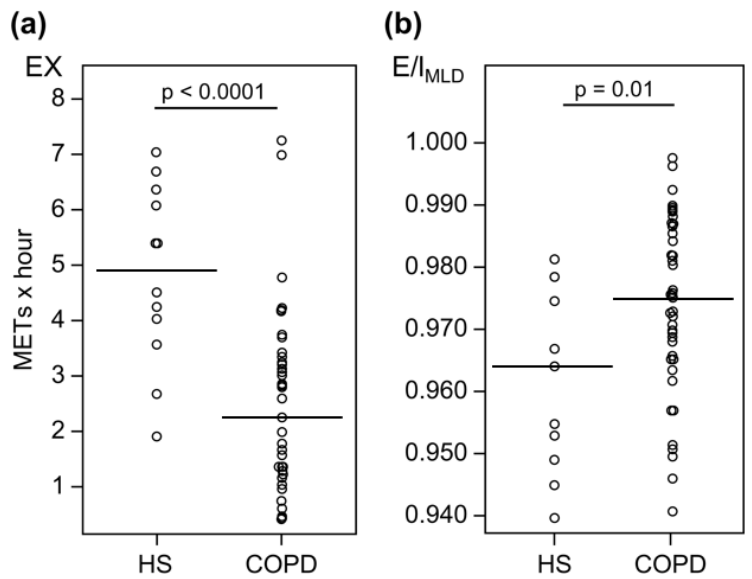
Figure 1. Comparison of EX ( a ) and E/I MLD ( b ) values between healthy subjects and patients with COPD. EX values are lower (median, 2.29 vs. 4.97 METs × hour; p < 0.0001) ( a ); while E/I MLD values are higher (median, 0.975 vs. 0.964; p = 0.01) for patients with COPD than for healthy subjects ( b ). Definition of abbreviations: HS, healthy subjects; COPD, chronic obstructive pulmonary disease; METs, metabolic equivalents; EX, exercise (METs × hour); E/I MLD , expiratory to inspiratory ratio of the mean lung density. The horizontal bars indicate median values.